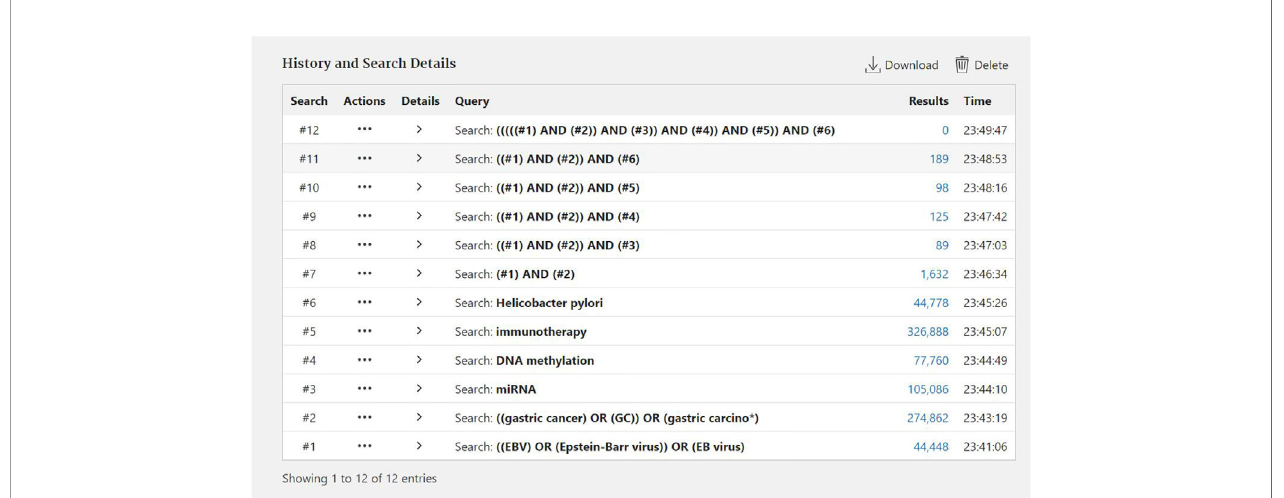
FIGURE 1 | The process of searching documents by